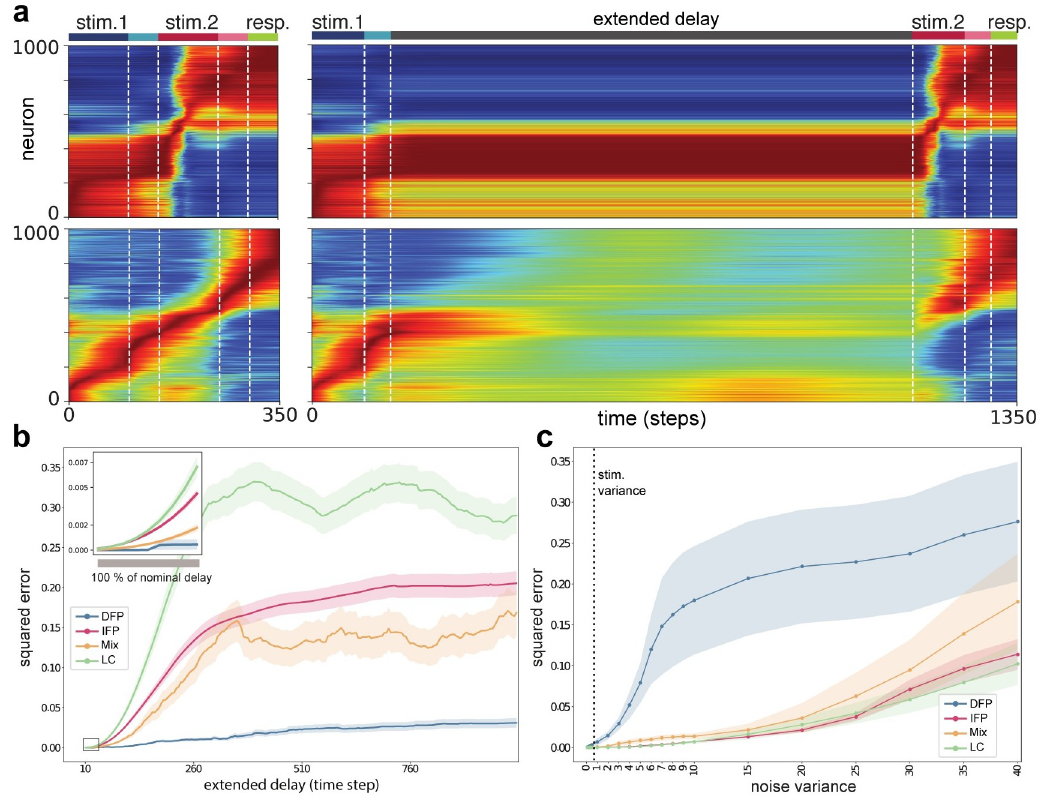
Fig 5. Functional advantages/disadvantages of each mechanism type. a , Comparison of activity patterns before and after increasing memory demand for DFP (top panel) and IFP (bottom panel). b , Summary of deviation from correct pattern of activity across different values of extended delay for all optimized networks. The squared error shows the difference between correct and deviated trial outputs averaged over all trials and associated networks. c , Summary of deviation from correct pattern of activity across different values of noise variance for all optimized networks. b and c show that IFP, LC and mixed mechanisms are forgetful, but robust to sizable